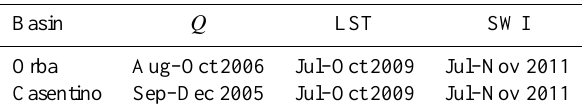
Table 4. Summary of the periods considered for the calibration pro- cess for each variable. In the case of M. O. approach the three peri- ods are